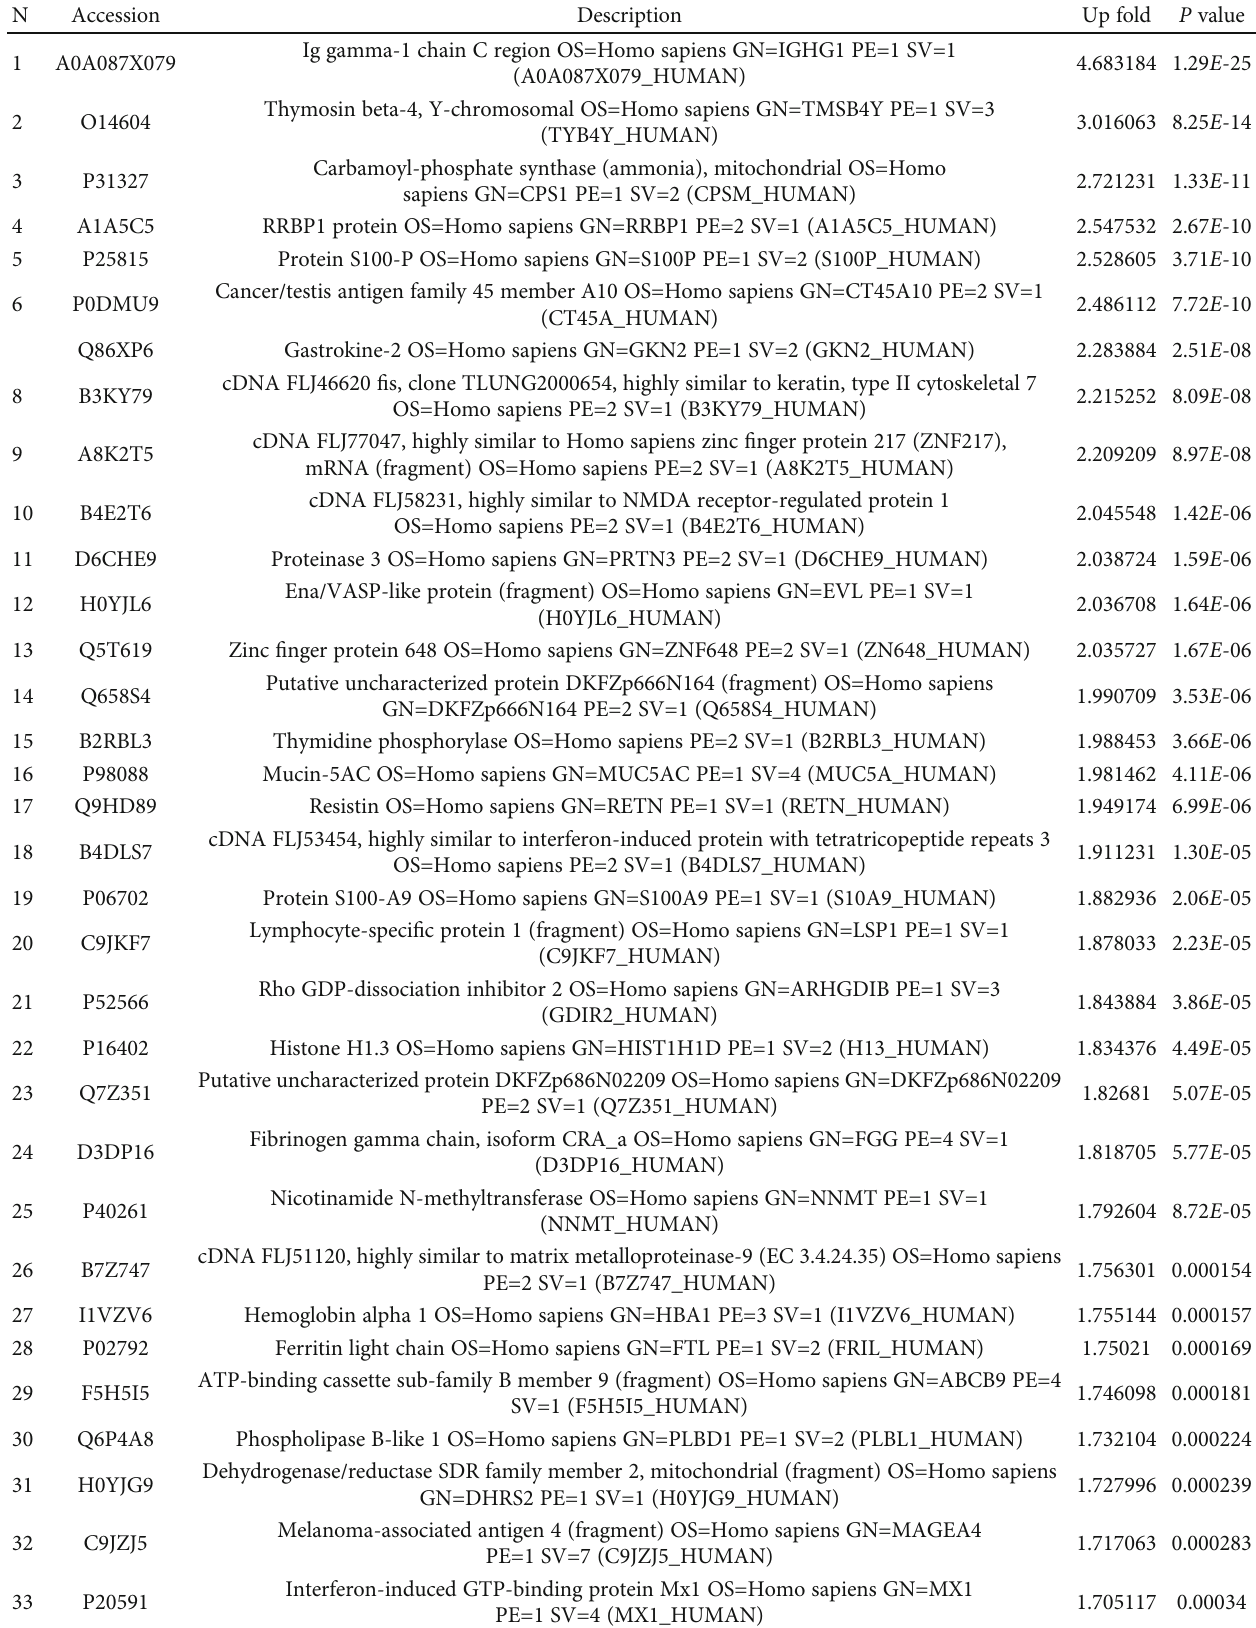
Table 1: The top 50 proteins with upregulation multiples greater than